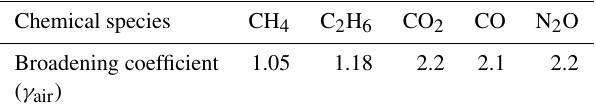
Table 1. Empirically determined water vapor foreign broadening